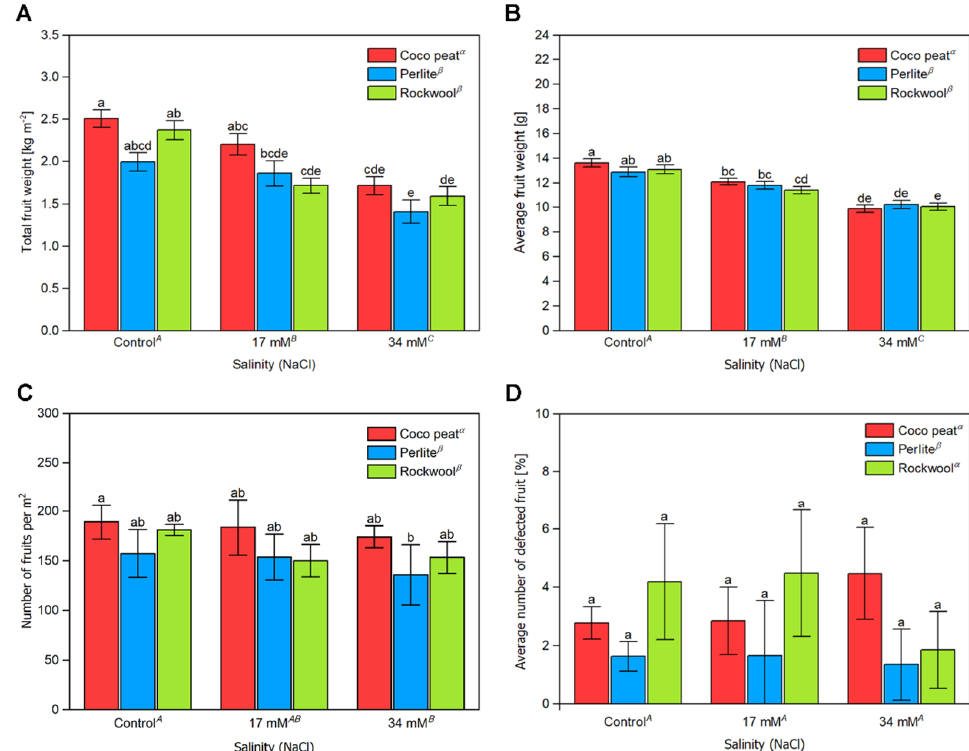
Figure 2. The yield of tomato cherry fruits, grown in different substrates with increasing salinity. The total fruit weight ( A ), average fruit weight ( B ), number of fruits per m 2 ( C ) and average number of defective fruit ( D ) of tomato cherry fruits, grown in coco peat, perlite and Rockwool with increasing salinity by NaCl from nine harvests between 14 August and 17 October 2017. The error bars represent the SD. Upper-case letters compare the salinity treatments, Greek letters compare different substrates, lower-case letters within the graph compare single mean values of the treatments. The raw data are available in Supplementary File S1. Table 1. Yield loss and salinity yield decrease (SYD) for cherry tomatoes grown in different substrates and